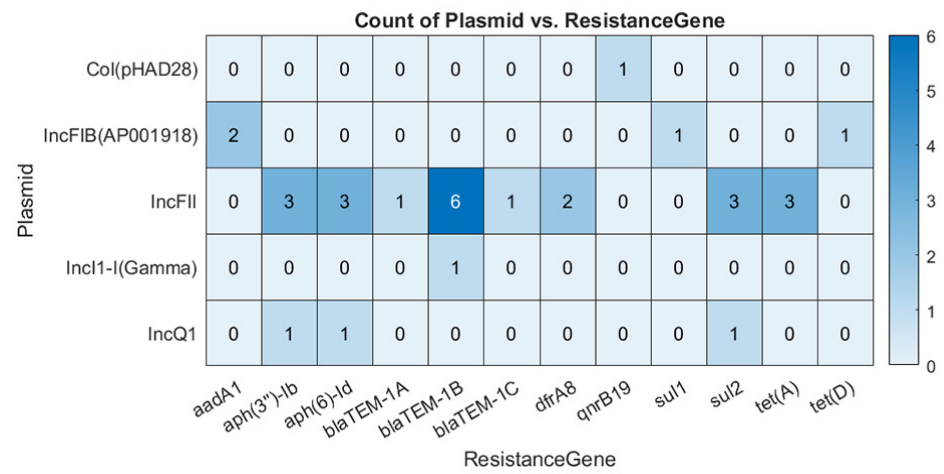
Figure 2. The co-existence of ARG Plasmid genes and different plasmids detected by PlasmidFinder in plasmid data from E. coli isolates. Numbers inside each cell indicating the number of isolates where ARGs were found on the corresponding plasmid.